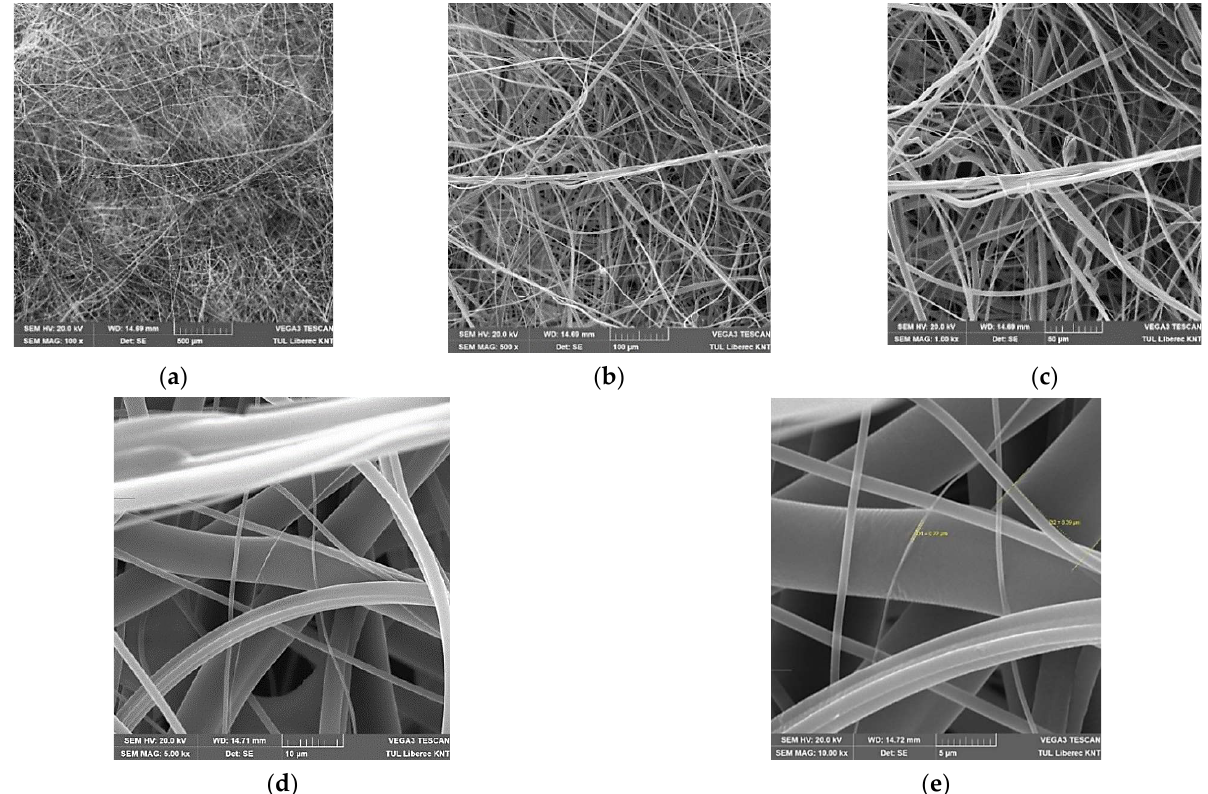
Figure 4. SEM images of prepared melt-blown layers at different magnifications: ( a ) 500 µ m, ( b ) 100 µ m, ( c ) 50 µ m, ( d ) 10 µ m, ( e ) 5 µ